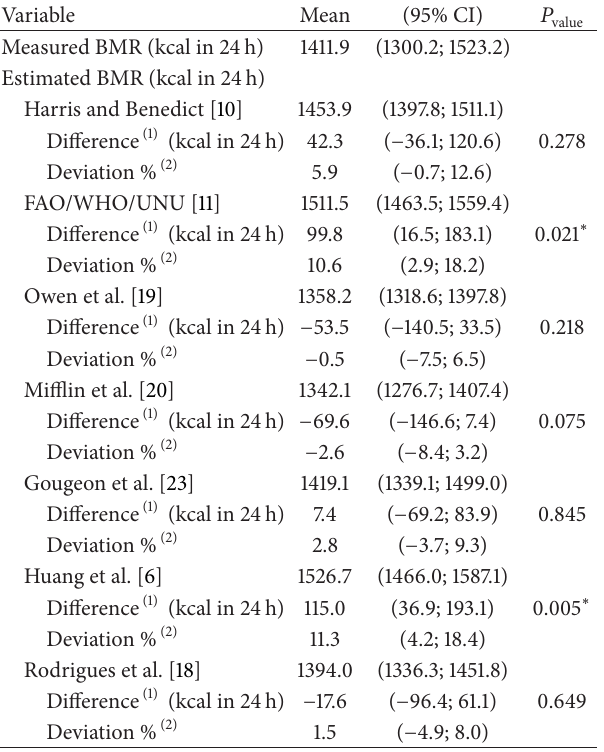
Table 3: Comparison between the estimated and measured BMR in women with type 2 diabetes